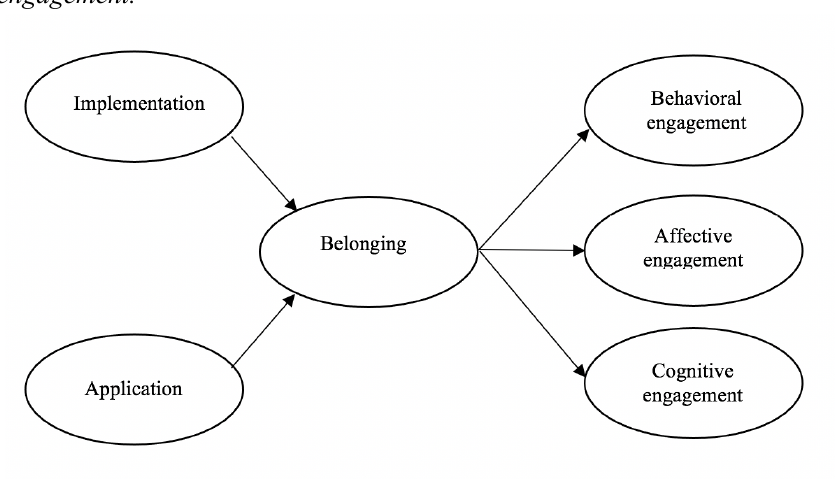
Initial Model. Model inspired by the work of Janosz et al. (1998) describing the links between classroom management, school belonging, and school